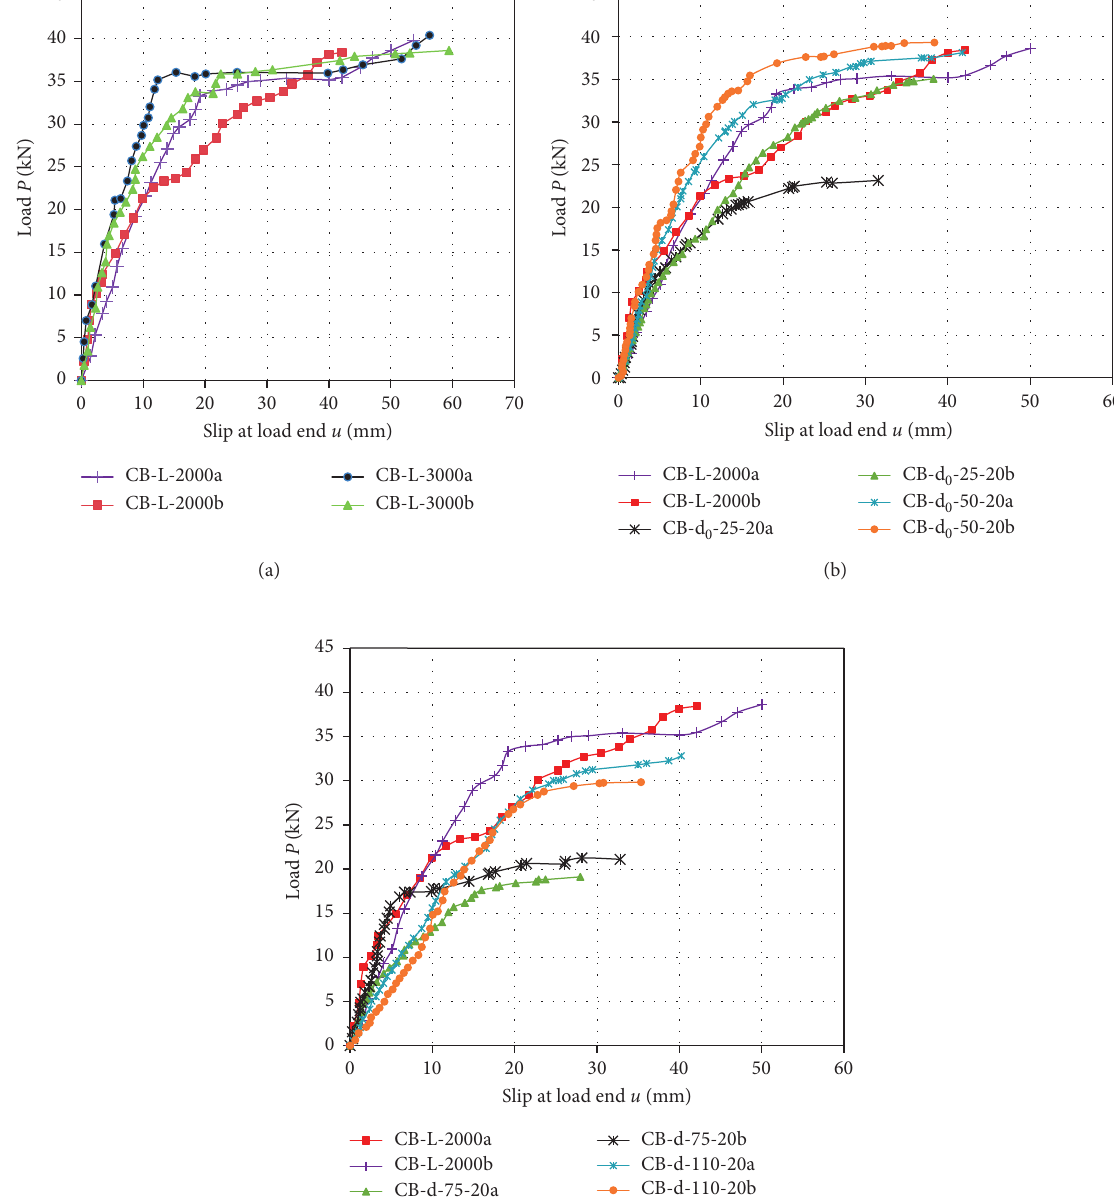
eff ). (a) Different bolt lengths. (b) Different bolt diameters. (c) Different